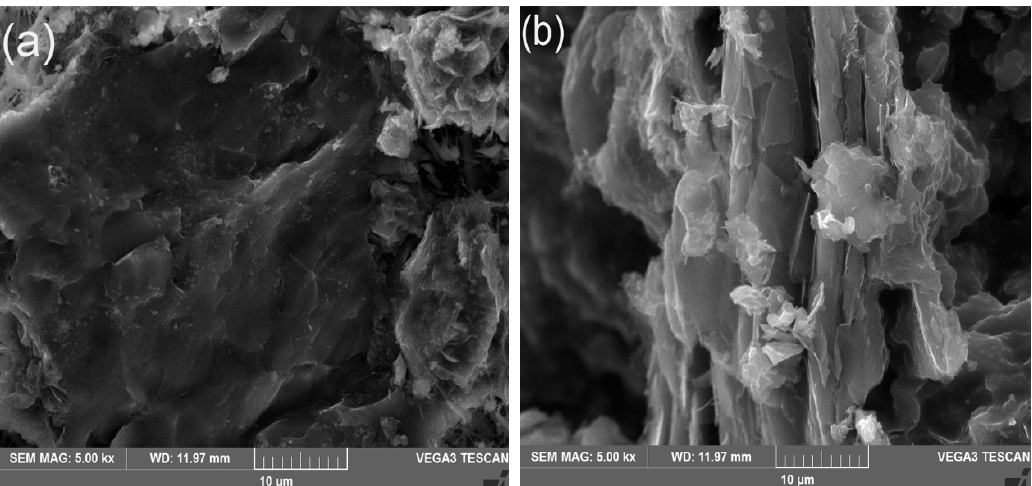
Figure 5. SEM images of fractured surfaces of carbon cathodes at testing 120 min with various current densities (a) 0.45 A/cm 2 (b) 0.7 A/cm 2 .